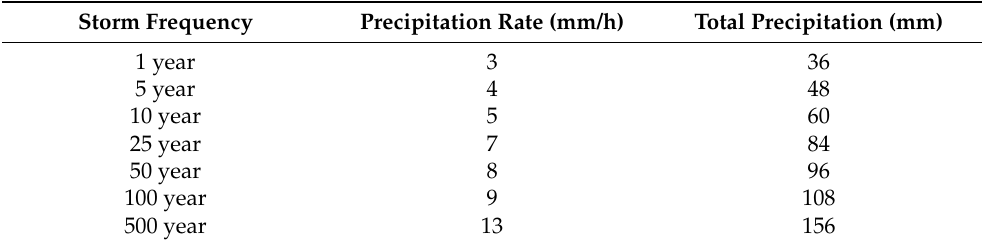
Table 3. Precipitation rates and total precipitation depth for various storm frequencies used to represent storm events in the simulations. Storm Frequency